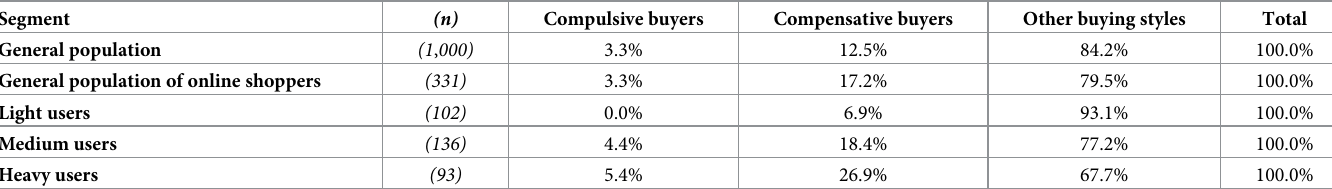
Table 2. Compulsive and compensative buyers by frequency segments.